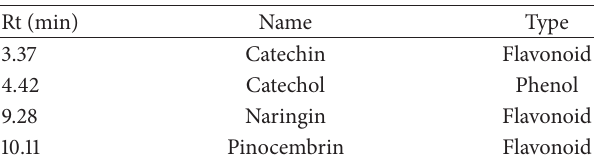
Table 2: HPLC analysis of AaEE. Table 3: GC-MS analysis of 𝐹 1 and 𝐹 2